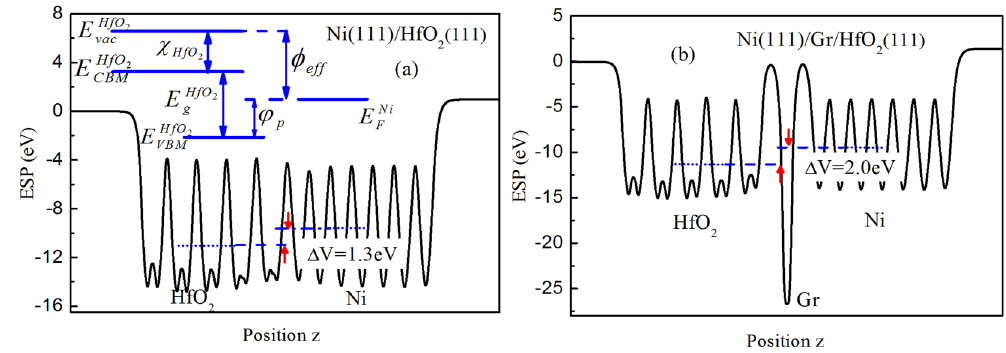
Figure 2. Plane-averaged potentials for ( a ) Ni(111)/HfO 2 (111) interface and ( b ) Ni(111)/Gr/HfO 2 (111)